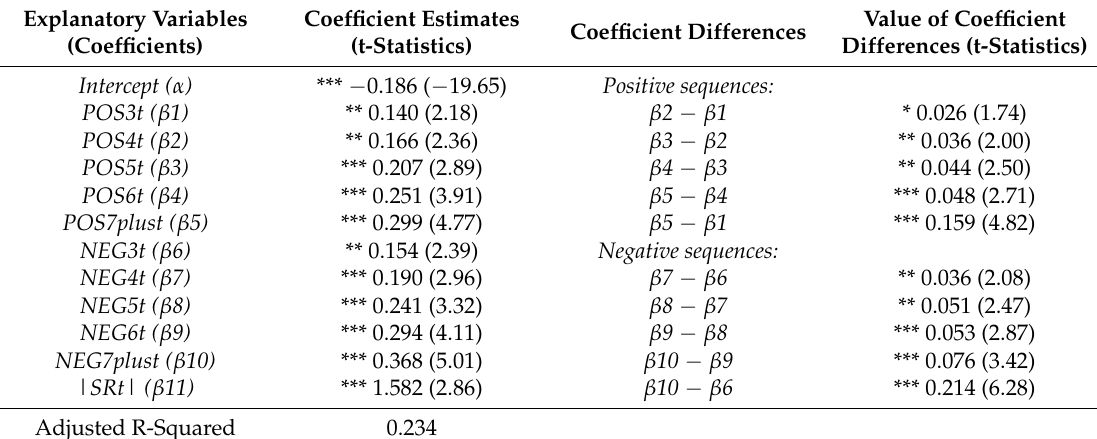
Table 3. Regression analysis (regression (3)): Return sequence effect on stock trading volumes (Dependent